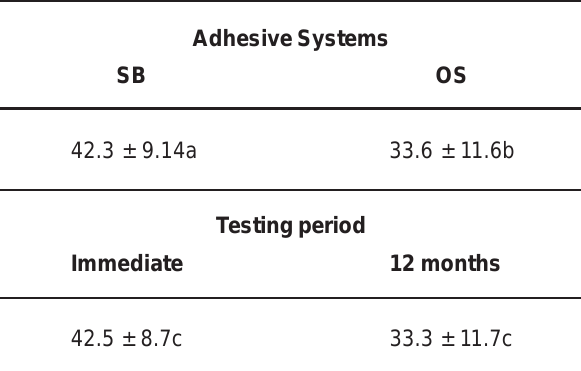
TABLE 3- Bond strength means (MPa) and standard deviation for each adhesive system and testing period*